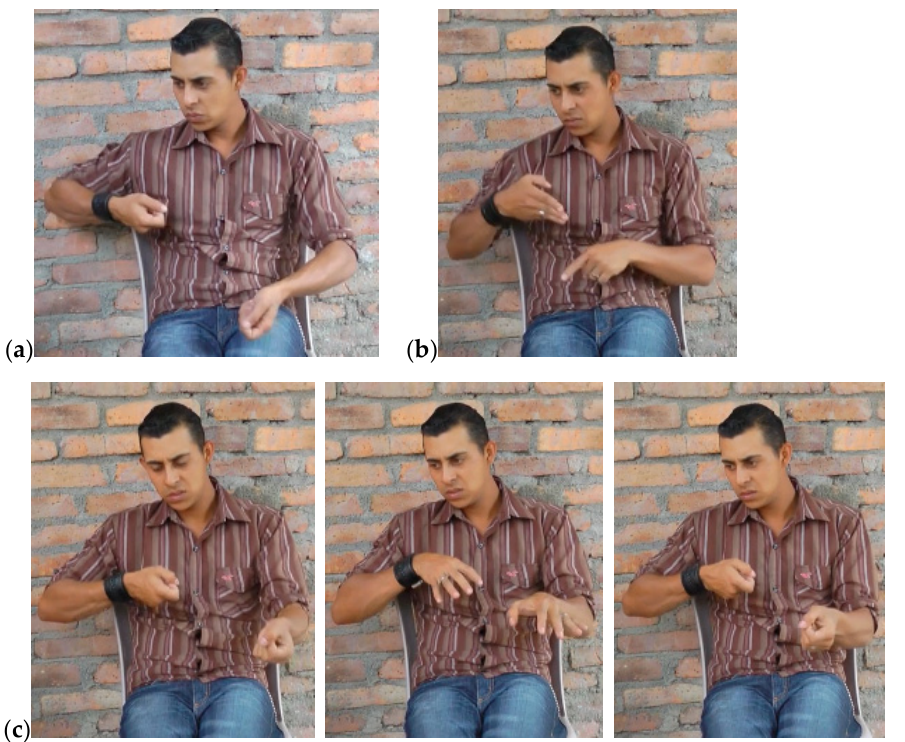
Figure 1. Examples for responses of iconic handshape types: ( a ) Handling [mop], ( b ) Object [hand saw], and ( c ) Handling+Object [rake]. See supplementary materials to view video clips of responses. Table 3. Percentage of responses that were a single sign/gesture versus multiple signs/gestures for each group. Most common response type for each group is